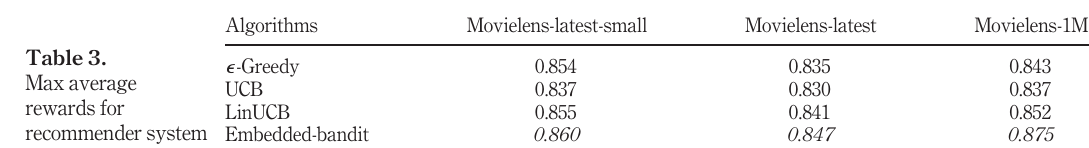
rewards for recommender system